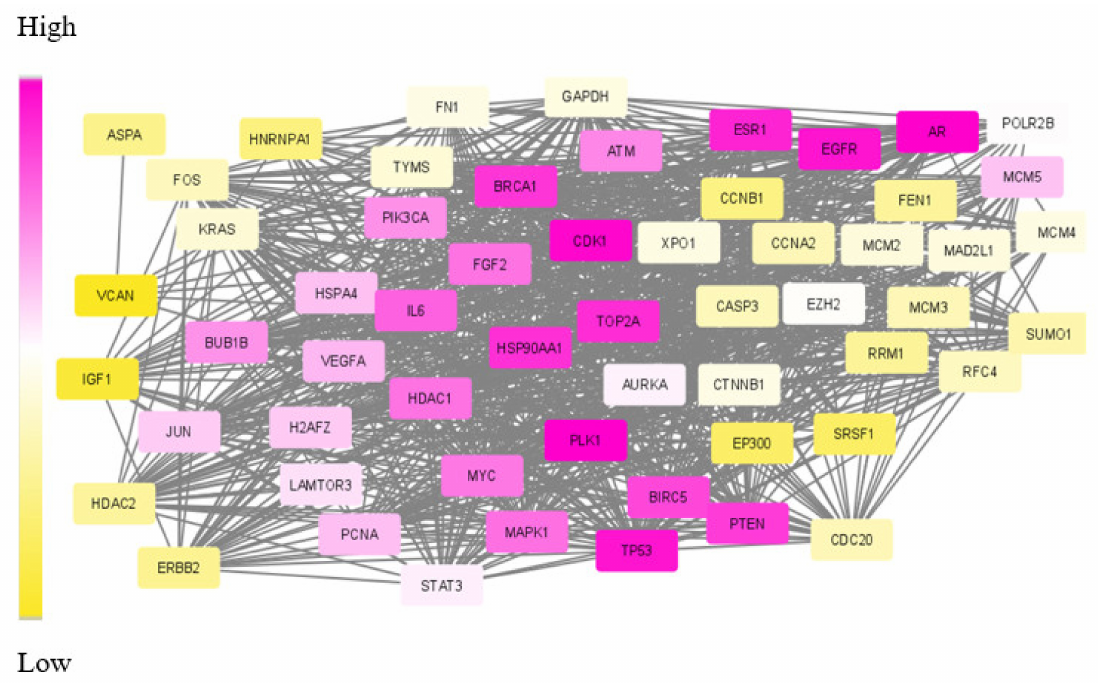
Figure 5. Visual representation of SDA derived dys-regulated subnetwork for Triple Negative Breast Cancer (TNBC) with 60 nodes and 940 edges. The nodes correspond to the genes in the optimum path with optimum weight values. The varying weights in increasing order is represented as colour gradient between yellow and purple.